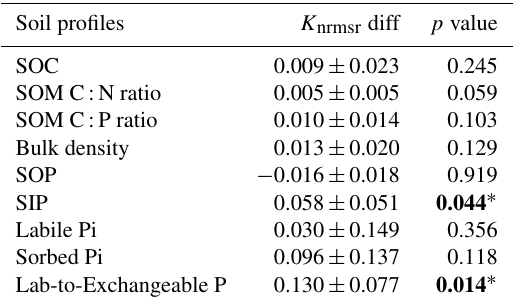
Table 3. Results for the paired t test between the normalized root- mean-square ratios ( K nrmsr ; Table S1) of the siLang and dbLang models of measured soil profile properties at all study sites. The null hypothesis is that dbLang performs no differently than siLang (i.e., dbLang has the same K nrmsr values as siLang), and the hy- pothesis is rejected when the p value is smaller than 0.05 (values in bold with an